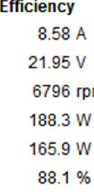
Table 1. Optimal characteristics of a Multistar Elite 5008-330 motor using a 6S battery pack.